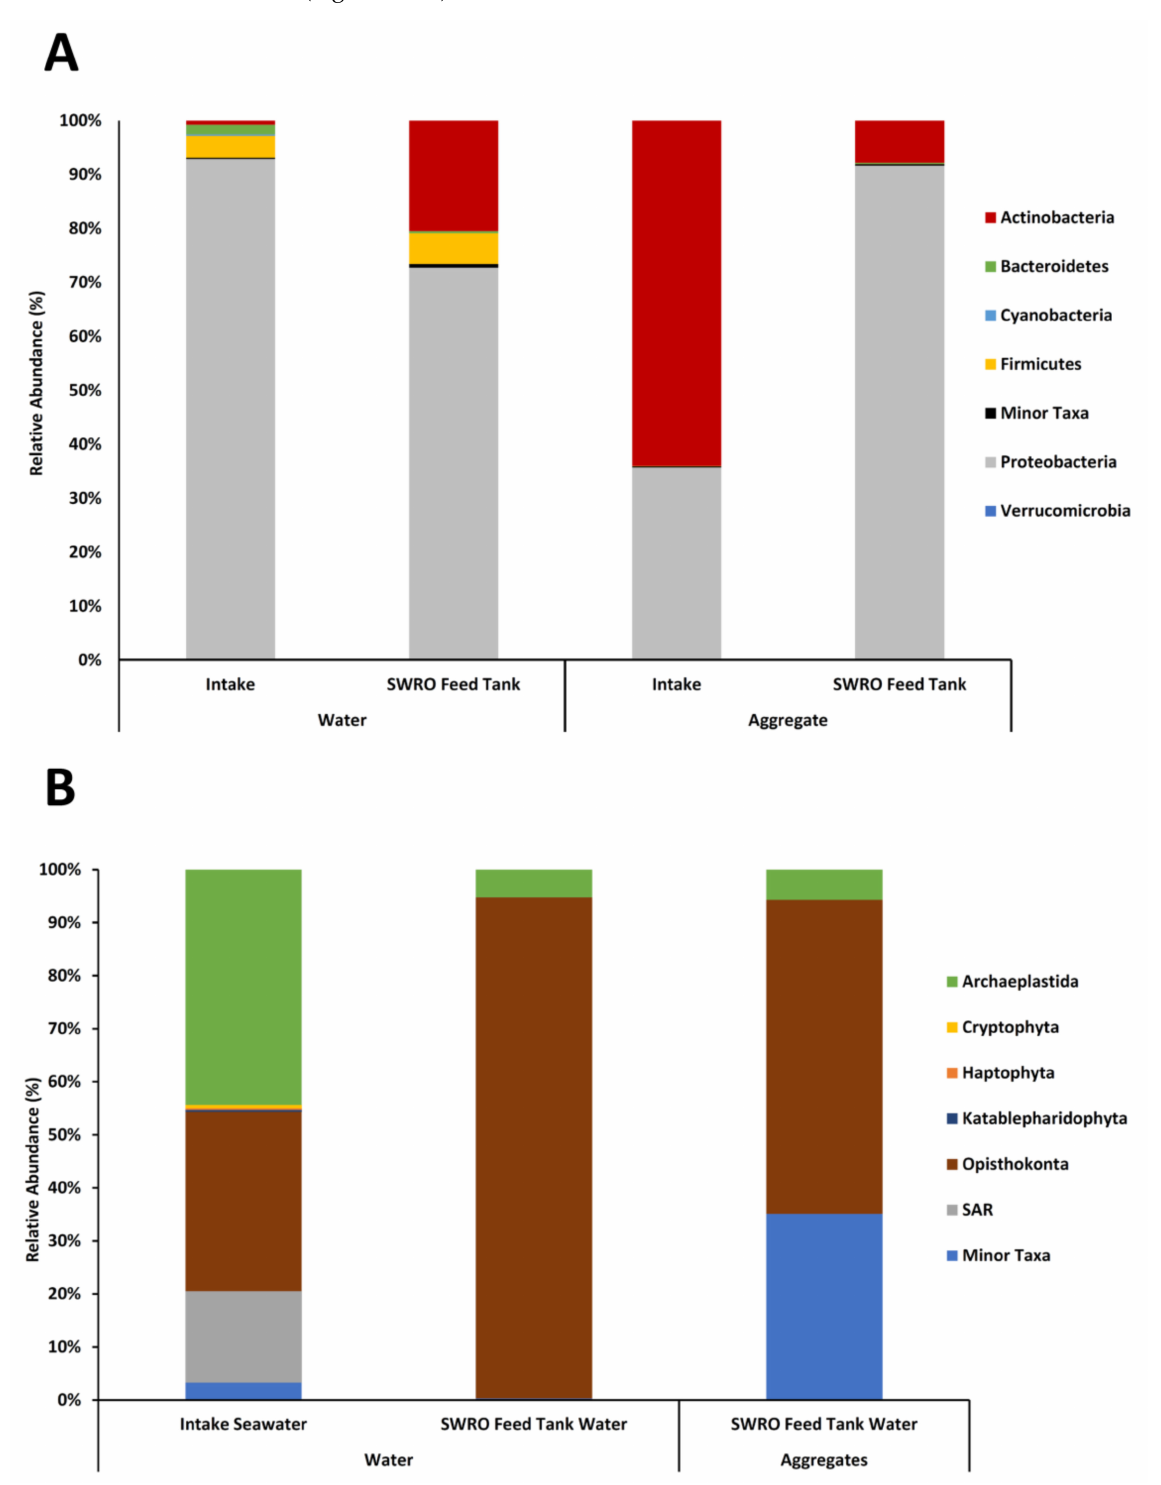
Figure 3. The relative abundance composition of the phylum taxonomy of the intake seawater and SWRO feed tank water samples ( A ) of the prokaryotic communities of the water and aggregate sample and ( B ) eukaryotic communities of the water and aggregate